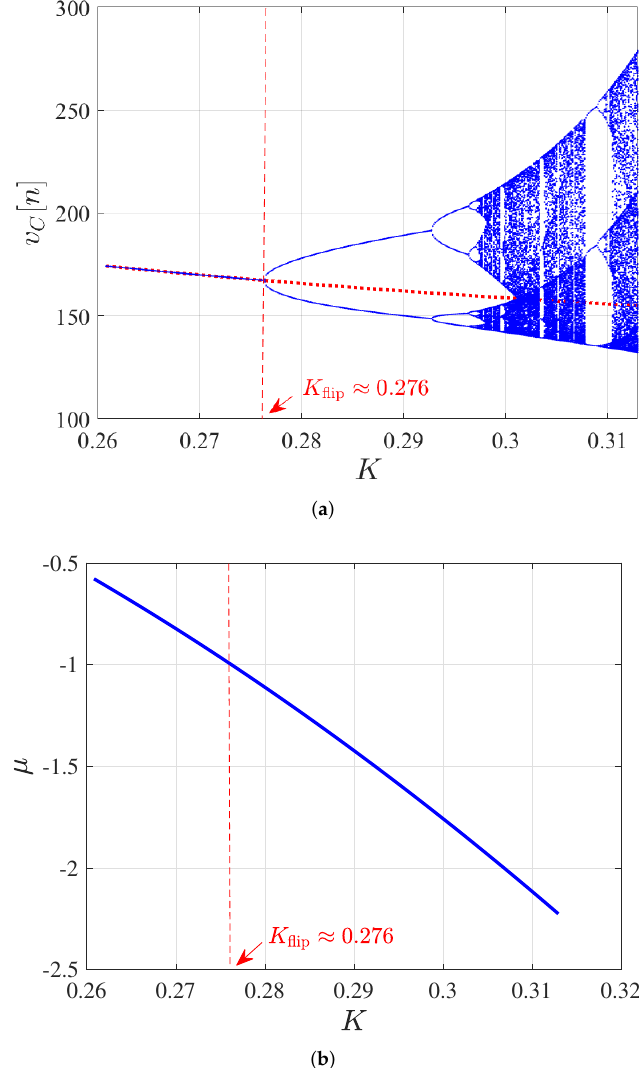
Figure 13. ( a ) Bifurcation diagram of the open-loop-DCM-operated boost converter with a CPL obtained using the approximated discrete-time model. The evolution of the fixed point is also represented by the dotted line. ( b ) Characteristic multiplier µ